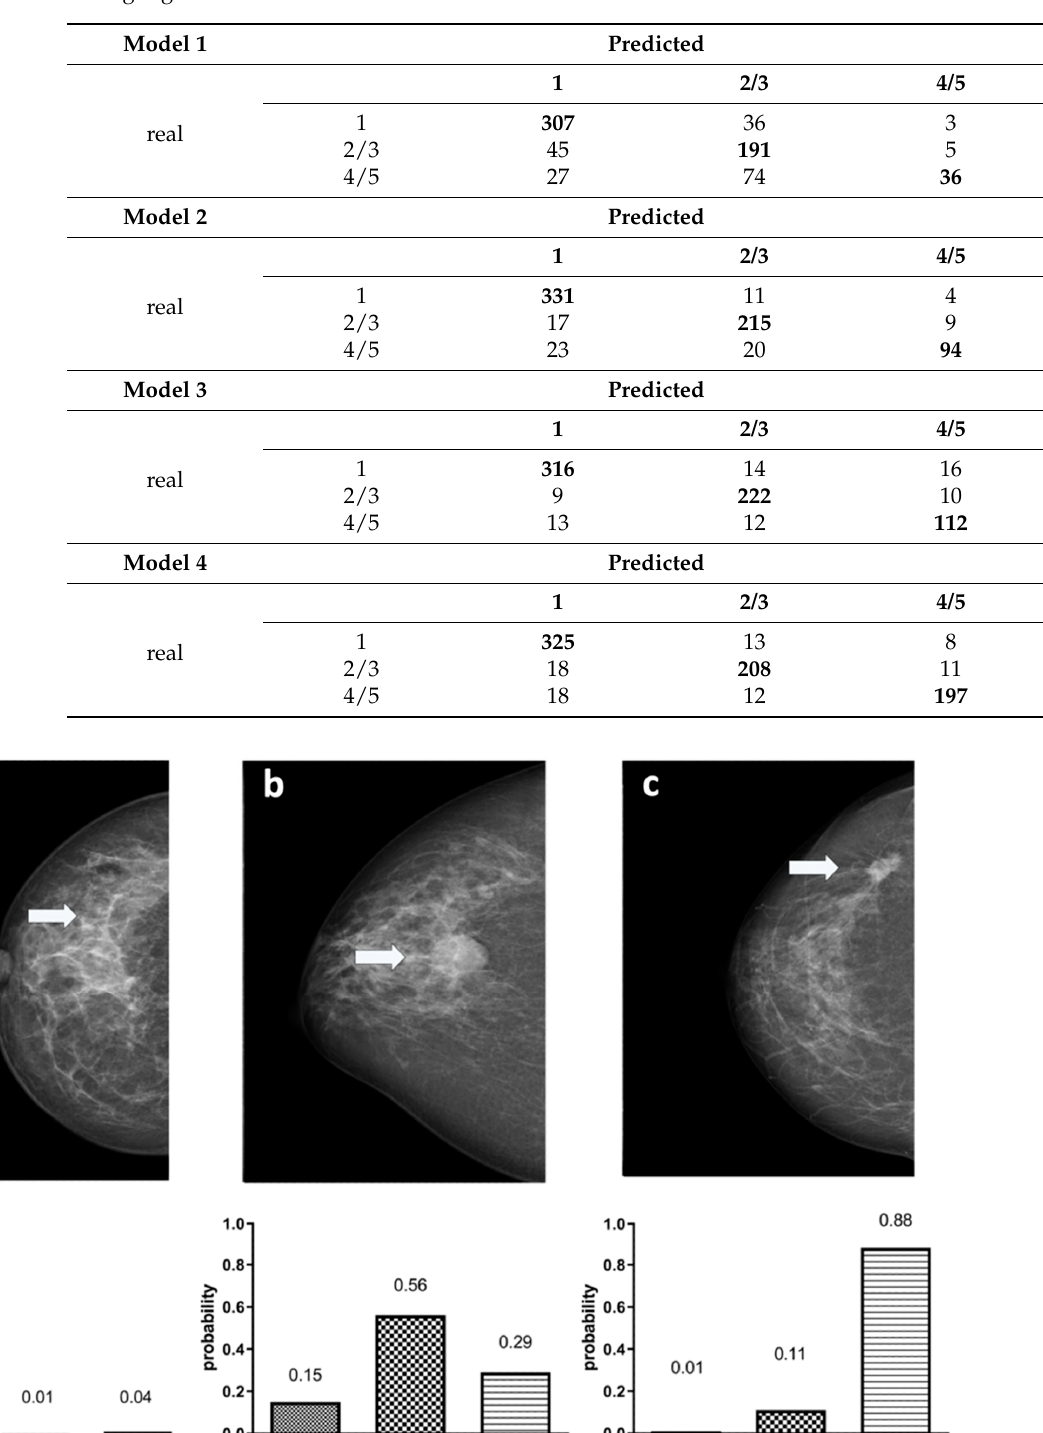
Table 2. Confusion matrices of the different dCNN models (1–4) on the test dataset, with 1: “healthy tissue”, 2/3: “probably benign opacities”, 3/4: “suspicious opacities”. The correctly assigned classes are highlighted in bold.